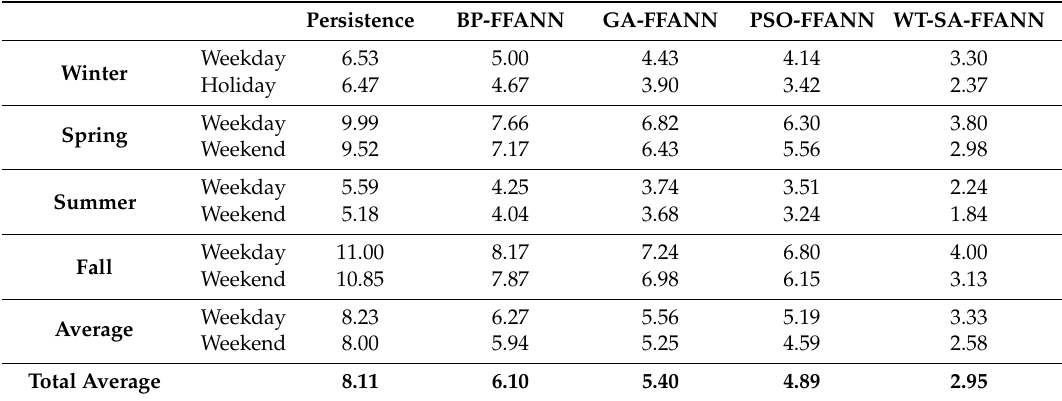
Table 4. Comparative MAPE